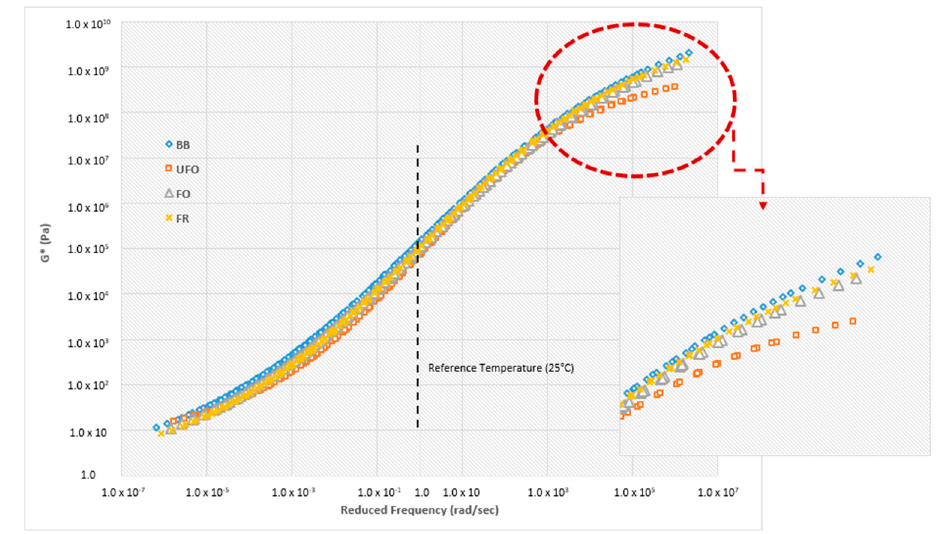
Figure 16. Comparison of master curves for RTFO-aged samples.